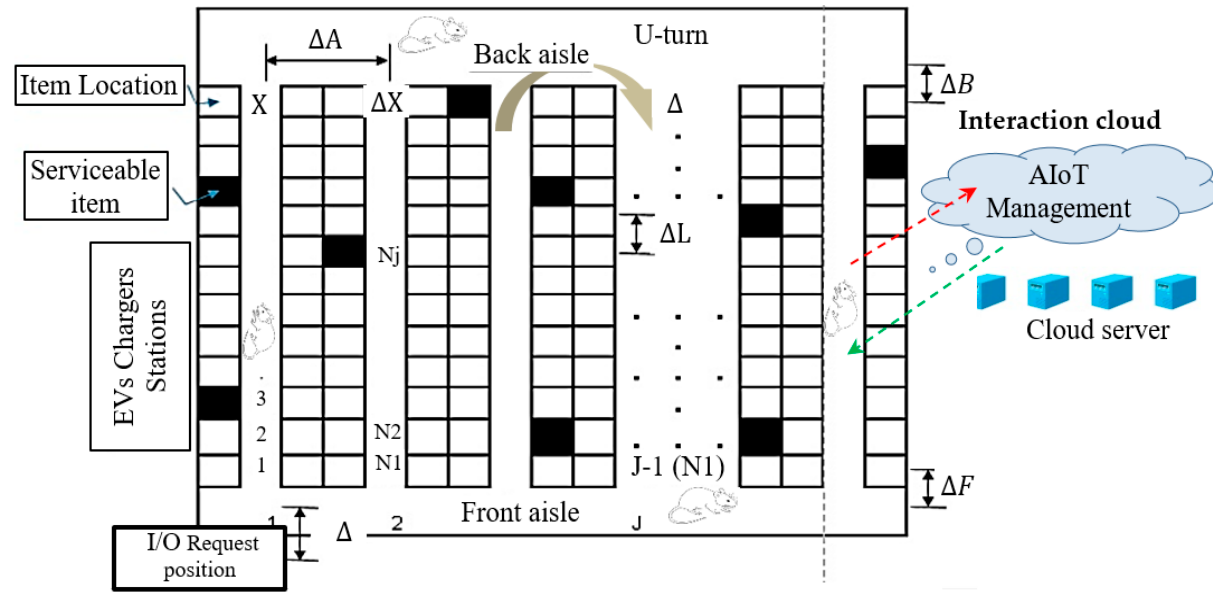
Figure 3. The map layout of state available direction and electric charger stations.